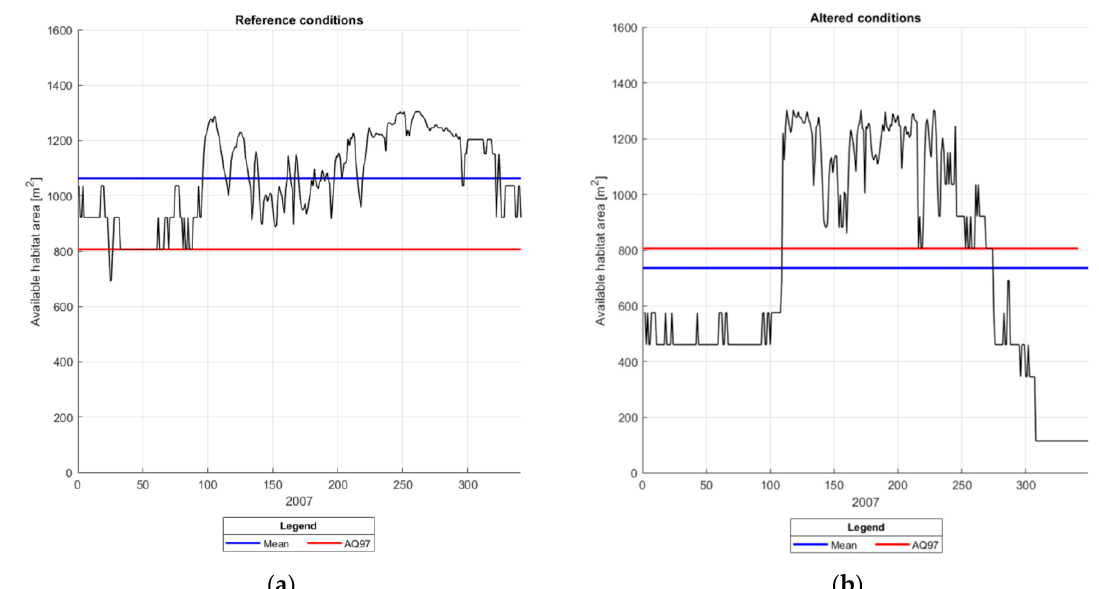
Figure 2. Comparison between habitat time series for ( a ) reference (with no withdrawals) and ( b ) altered conditions (when the withdrawal is present) for the adult trout in the Savara stream (Aosta Valley, Italy). The considered period is January–December 2007. The available habitat area (total square meters) is shown on the y-axis. The blue line represents the average value of habitat availability in the considered period, used for the ISH calculation, while the red line indicates the minimum habitat threshold during low flows (A Q97 ) in reference conditions, used for the ITH calculation.